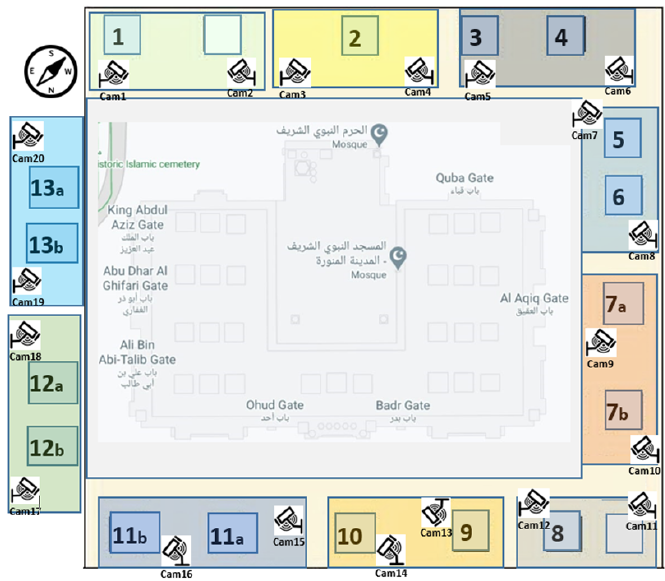
Figure 3. Proposed cameras setups and spatial distribution of Al-Nabvi mosque,